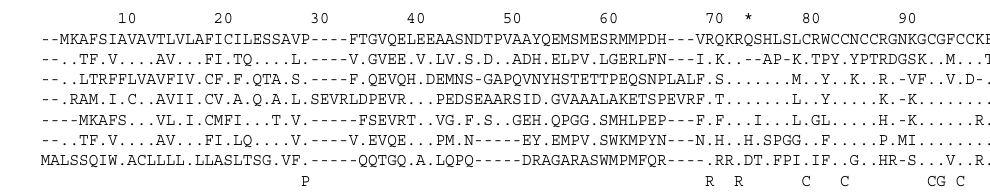
Figure 3. Alignment of hepcidins. Representative precursor peptide sequences were obtained from published data and from the PubMed protein database, and were aligned using MacVector software. Human hepcidin is shown for comparison. The first residue of the mature peptide region is denoted with an